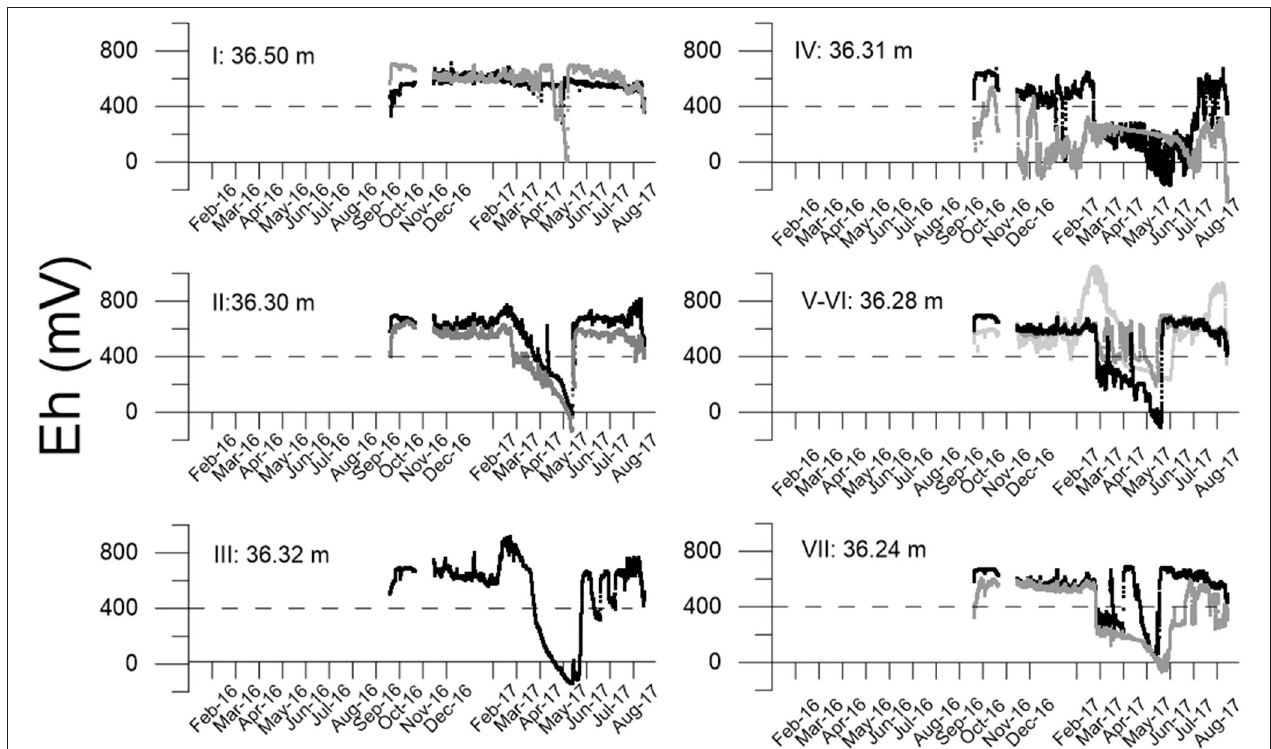
FIGURE 6 | Redox measurements in location C. Individual sensor location marked, m a.s.l. Dotted line – 400mV reference for aerobic/anaerobic soil